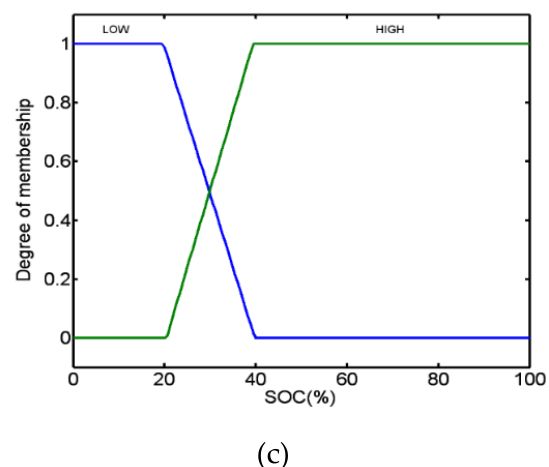
Figure 3. Input attribution functions of ( a ) electric position, ( b ) vehicle speed, and ( c ) state of charge (SOC).